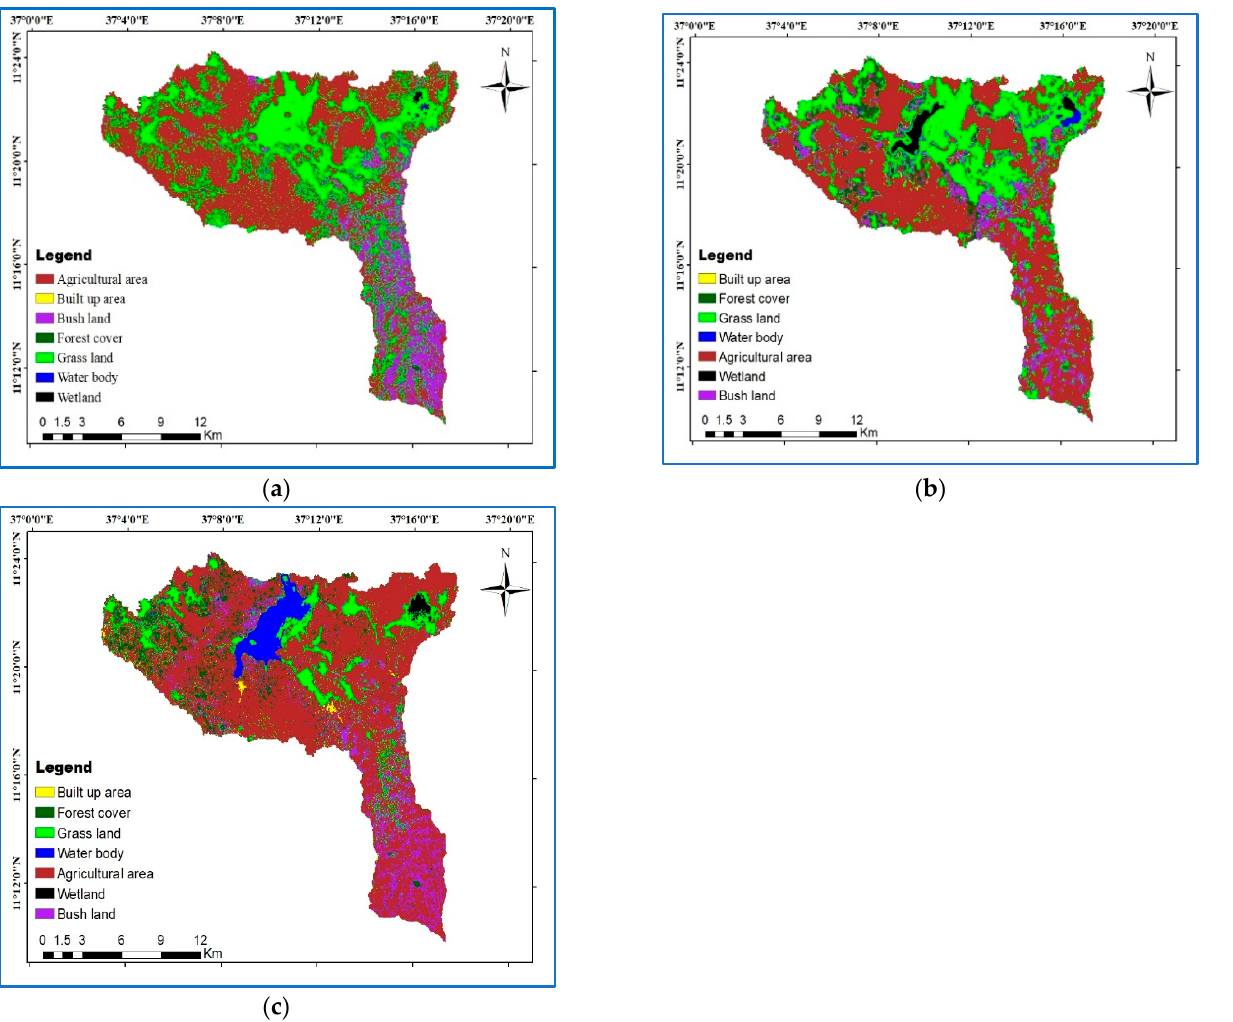
Figure 3. The classified land use/cover map of 1991 ( a ), 2008 ( b ), and 2018 ( c ).